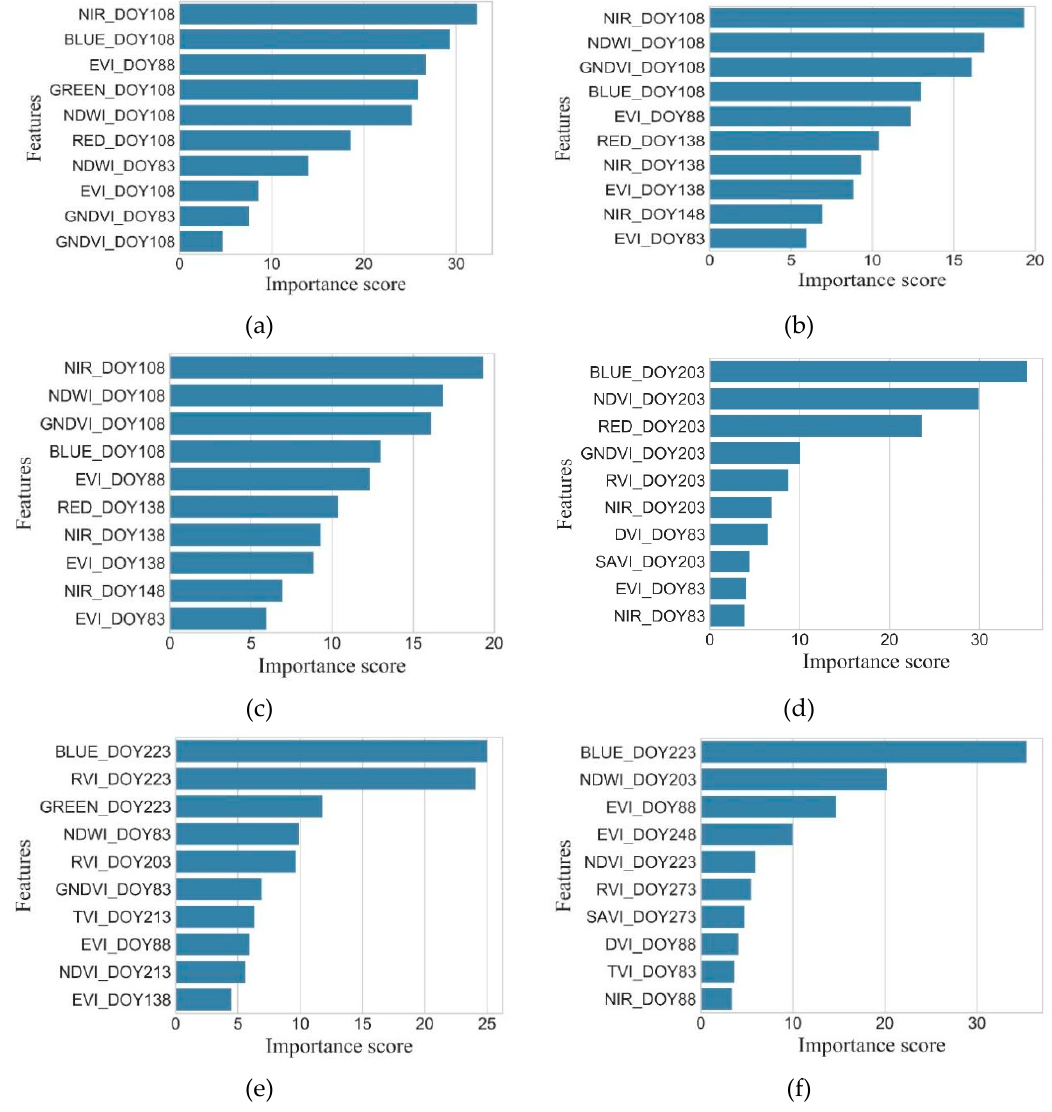
Figure 10. Top ten features in different time series lengths. ( a ) March–April. ( b ) March–May. ( c ) March–June. ( d ) March–July. ( e ) March–August. ( f ) March–September.